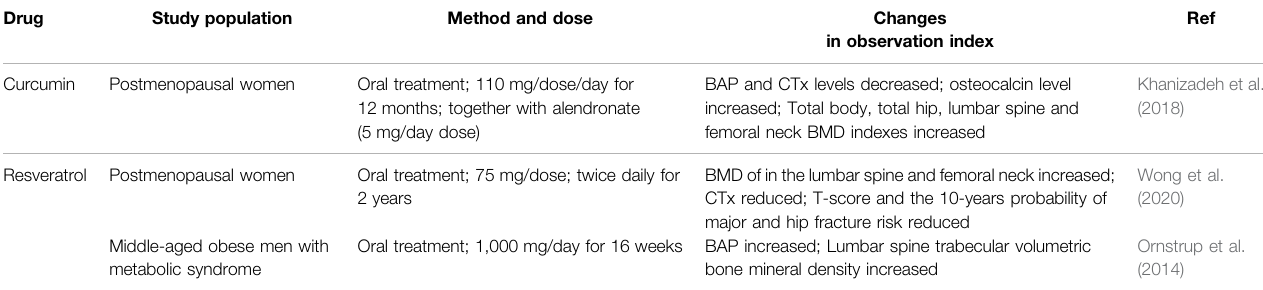
TABLE 3 | Clinical trials of HO-1 inducers for osteoporosis.